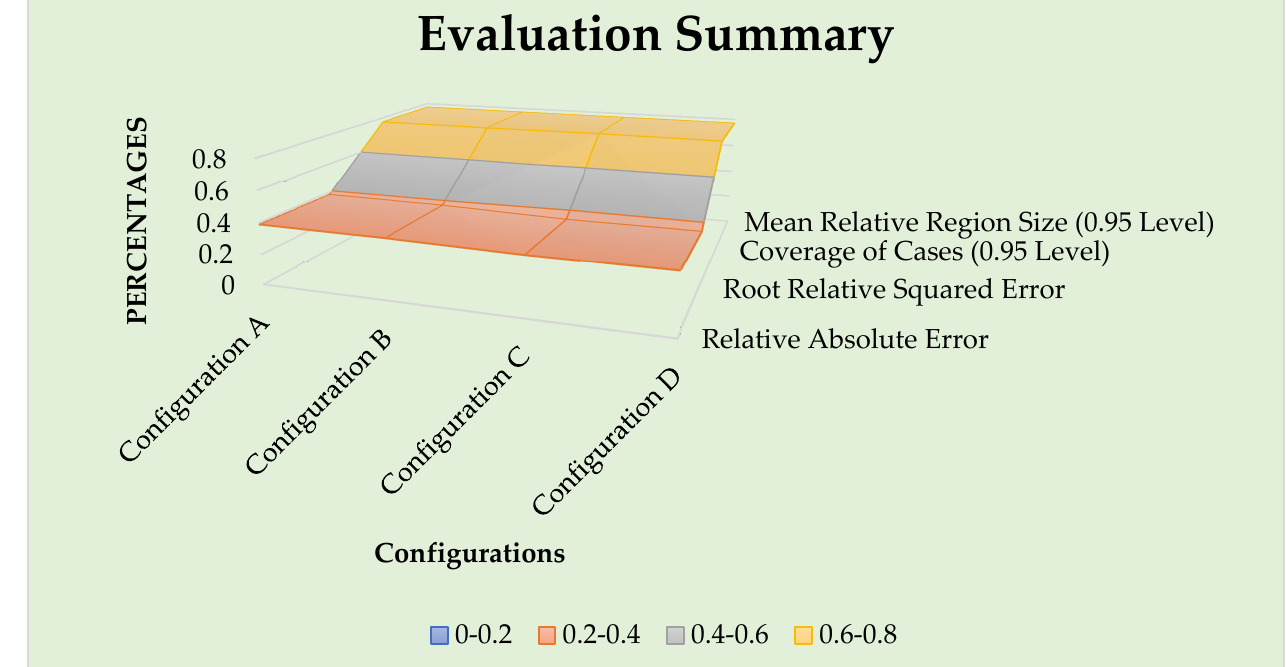
Figure 11. Graphical representation of evaluation accuracy (tetrad feature selection techniques).